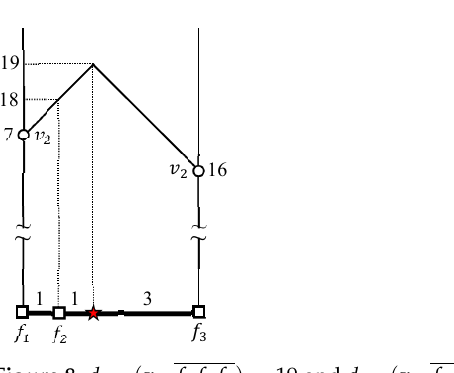
Figure 8. d max ( v 2 , f 1 f 2 f 3 ) = 19 and d min ( v 2 , f 1 f 2 f 3 ) =